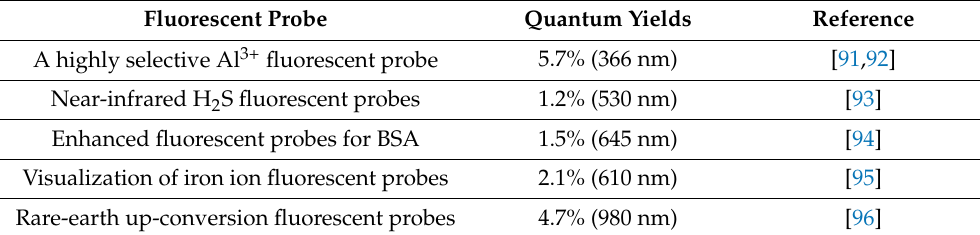
Figure 7. Energy level diagram and energy transfer mechanism of Yb 3+ and Ho 3+ . Table 3. Fluorescence quantum yields of fluorescent